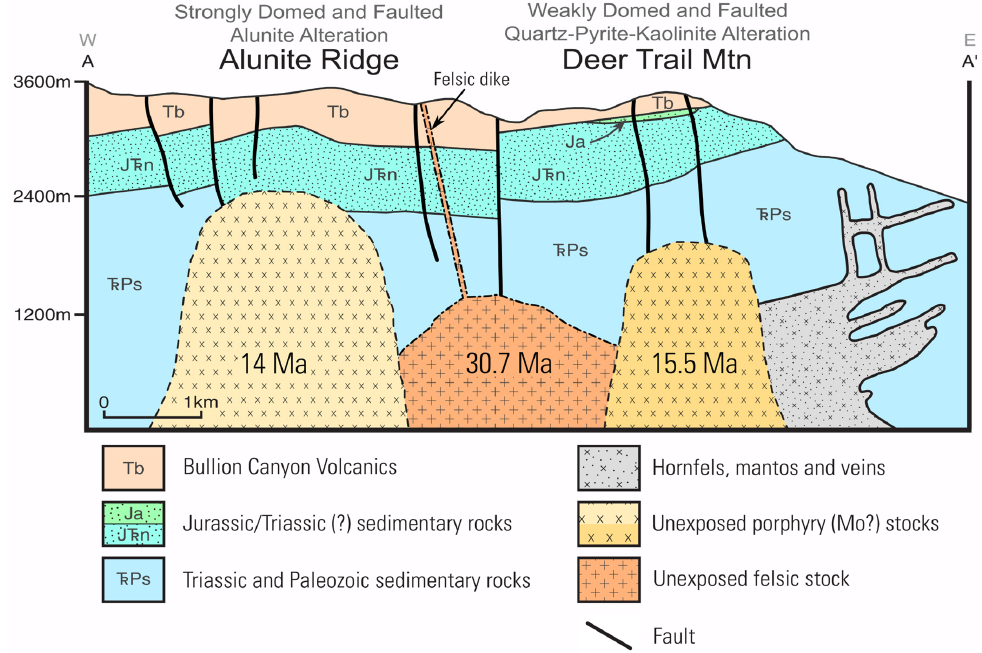
Figure 9. Schematic cross section showing the inferred position of multiple intrusive stocks beneath Alunite Ridge and Deer Trail Mountain (modified after Beaty et al. [14]). See Figure 3 for the location of the cross section. An Oligocene rhyolitic stock is inferred to be the source of rhyolitic quartz- porphyry dikes like the one dated at the upper Mineral Products mine and others at the Bradburn and Christmas mines. The two Miocene stocks (likely similar to those in Climax-type porphyry Mo systems) are inferred to be the sources for the magmatic volatiles that episodically produced magmatic-steam alunite during two periods at ca. 15.7–15.1 Ma and ca. 14.7–13.8 Ma. These periods of hydrothermal activity may have produced (or overprinted) the carbonate replacement deposit at the Deer Trail mine.